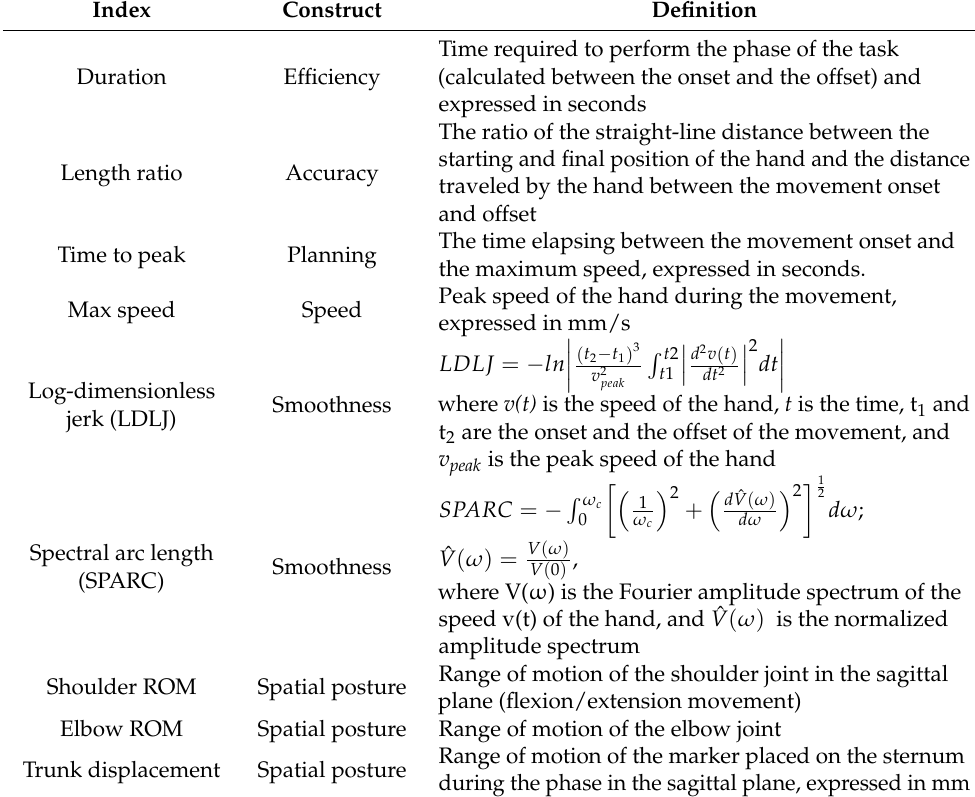
Table 1. Quantitative indices used to quantify motor performance in the drinking task. Each index is computed for each phase